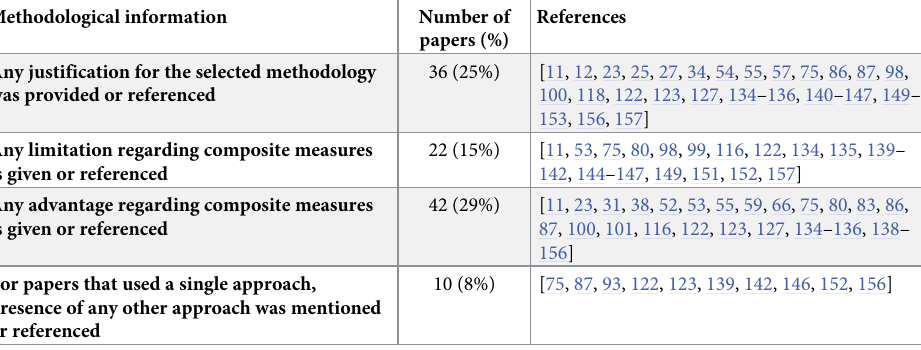
Table 4. Methodological information in publications reporting composite measures of quality of health care based on process